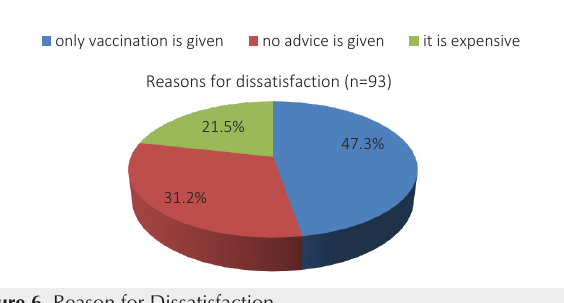
Figure 6. Reason for Dissatisfaction.